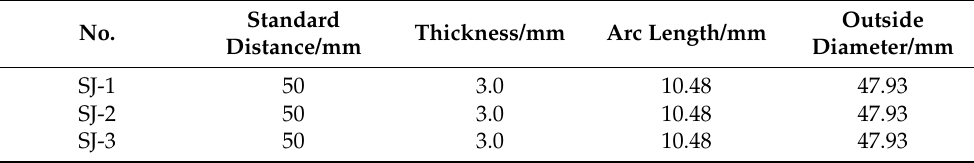
Table 4. Specimen size of the material property experiment.